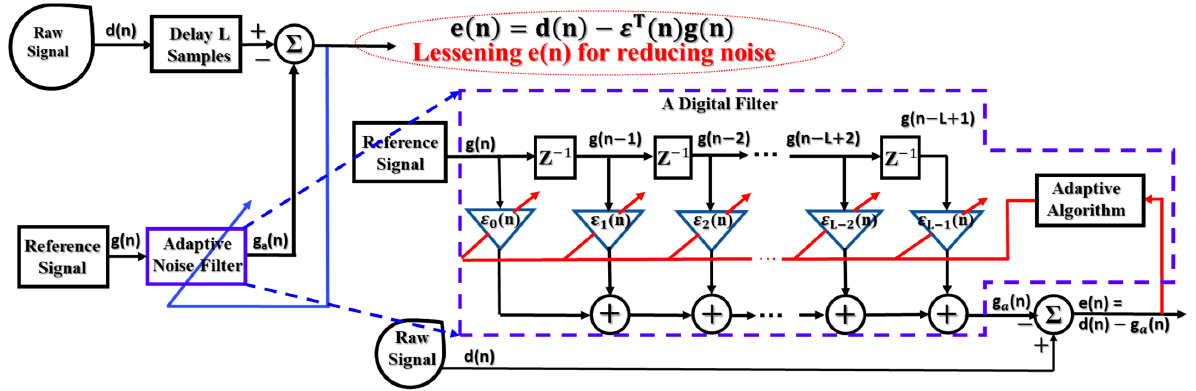
Figure 1. The functional structure of an adaptive noise filtering